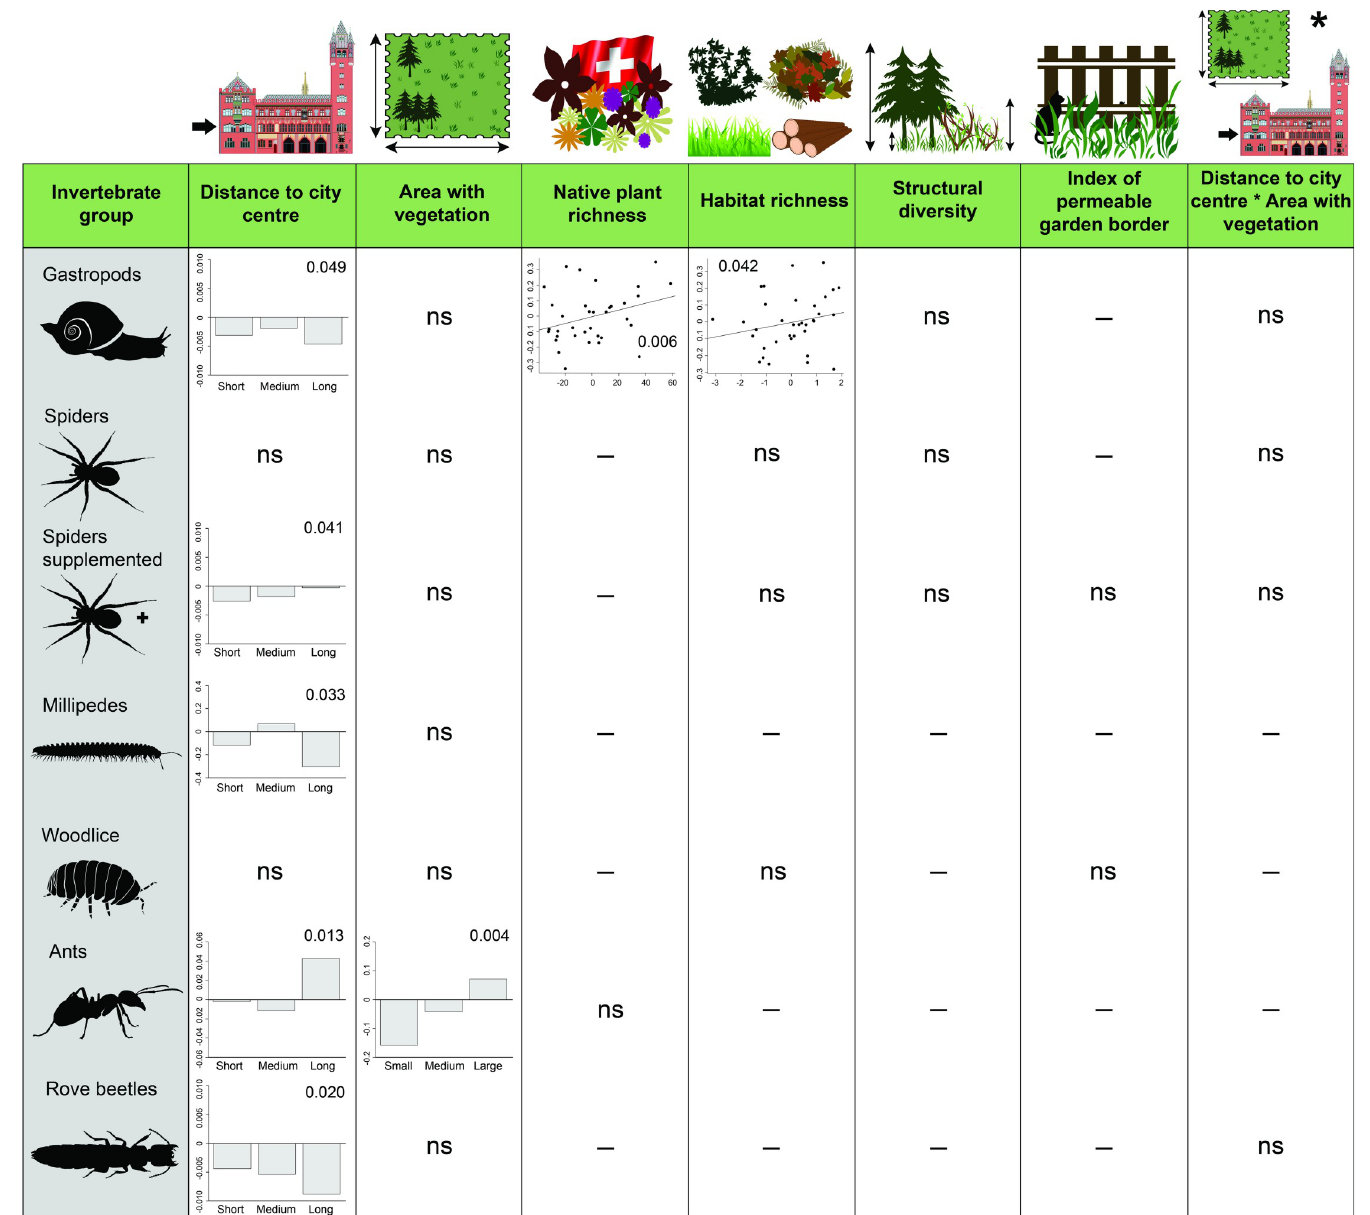
Fig 1. Effects of urbanisation (distance to city centre; three classes), garden size (area with vegetation; three classes) and local garden characteristics on the species richness of six groups of invertebrates. Plots show significant responses (P < 0.05) from GLMs (see Model 1 in S7 Table for more details). P-values for the response of the GLMs are shown. Displayed are deviance residuals for species richness from full models after stepwise reduction omitting the respective factor. This procedure corrected for other factors in the GLM. For native plant species richness, habitat richness and structural diversity, residuals from regressions of these factors on total garden area were used, because all three variables were correlated with garden size. Positive values in the bar plots indicate a higher than expected species richness. “–”indicates factors that were omitted from the models in the stepwise procedure. “ns” indicates factors that were retained in the model, but were not significant. For each family only represented by juvenile spiders, which were not identified to species level, we added an extra species to the count for the category spiders